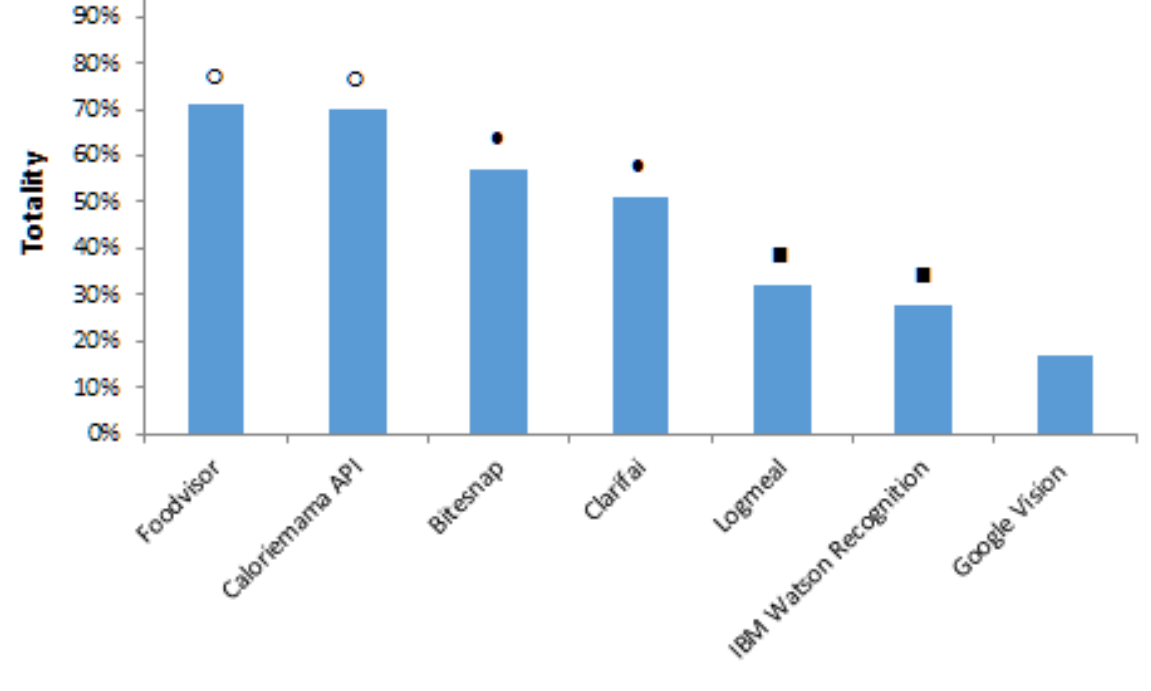
Figure 2. Totality of estimates on mixed dishes among different recognition platforms. Non-significant differences are denoted with a symbol placed with both platforms. All other platforms estimated mixed dish content to a significantly different level of totality (all P values ≤